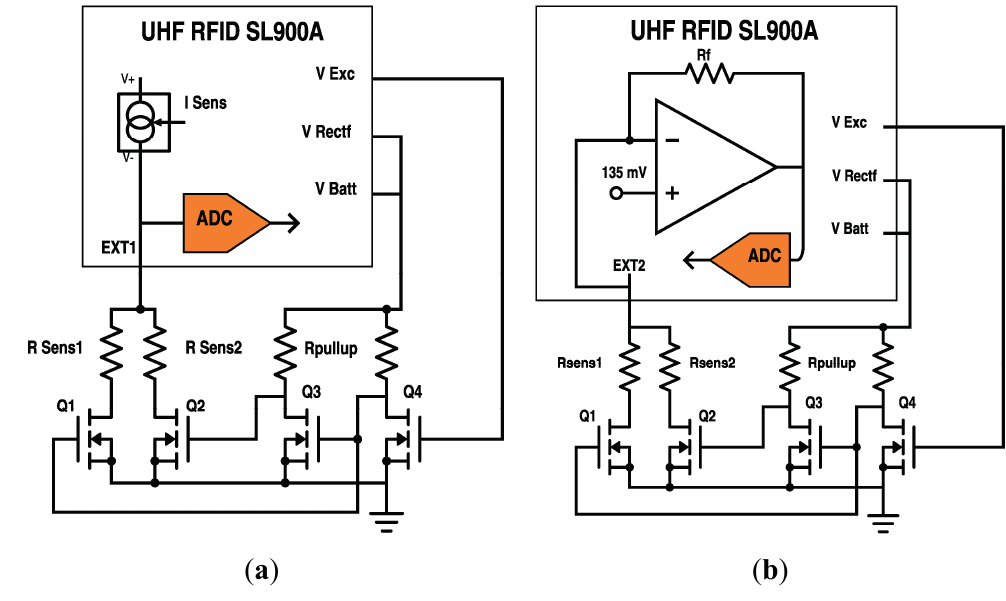
Figure 1. Schematics showing the two external resistive sensor modes of the RFID chip, including the extra circuitry to read each resistive sensor: ( a ) sensor with linear resistance variation; and ( b ) sensor with linear conductance